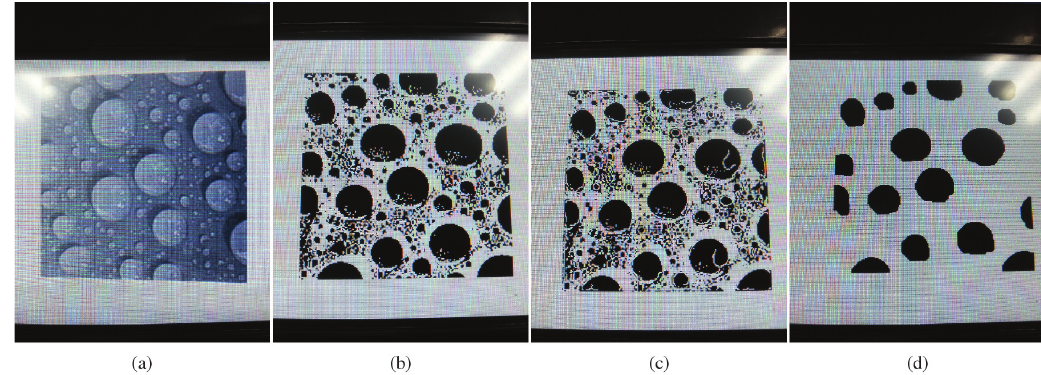
Figure 3. Results on LCD of the DSP platform. a)-d) represent the original image, threshold segmentation result, COAT result and final